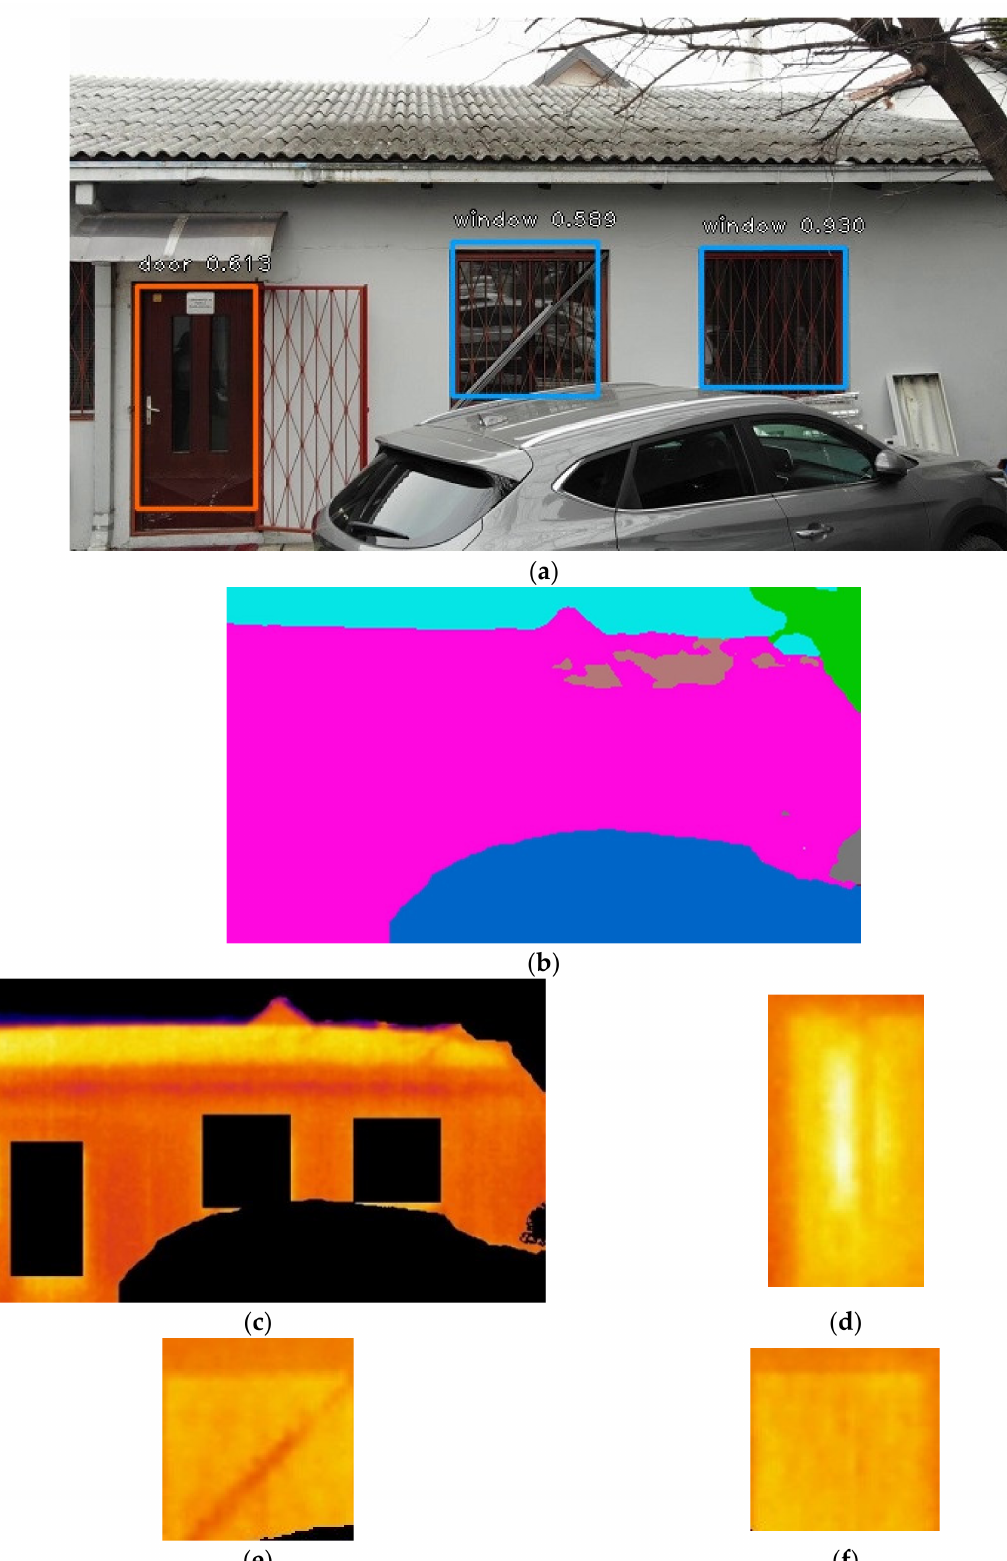
Figure 4. Frame processing: ( a ) successfully detected windows and door on visual frame; ( b ) segmented visual image; ( c ) IR frame with segregated windows and door; ( d – f ) extracted door and